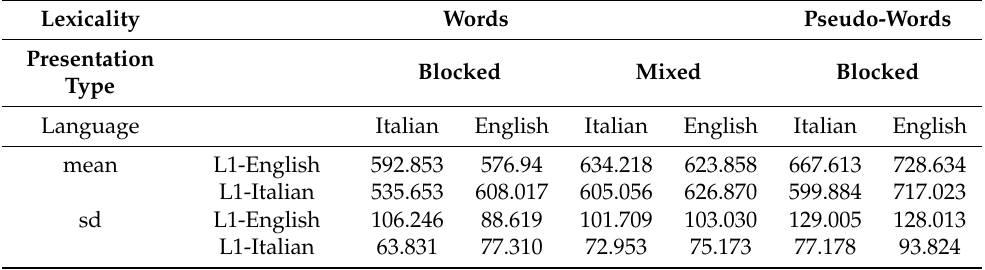
Table 3. Descriptive statistics for the reading tasks in the two groups.